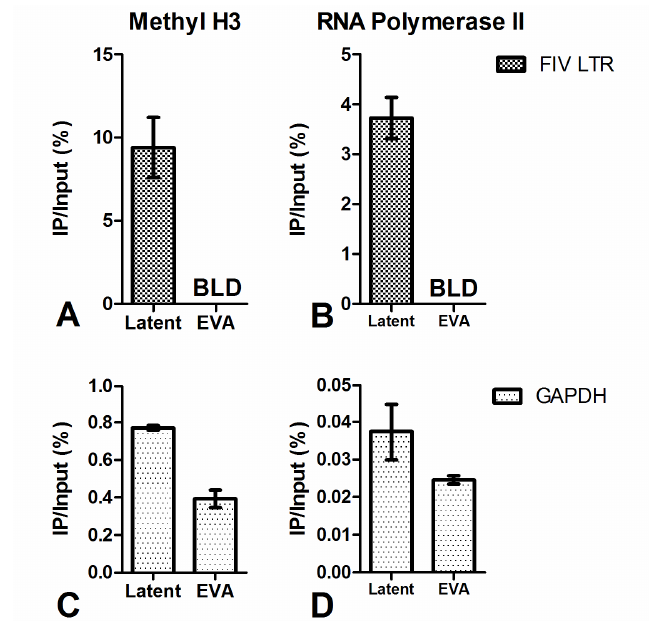
Figure 5. ChIP assay of FIV-infected CD4+ T-cells using anti-methylated histone H3 and anti-RNA Polymerase II antibodies. ( A ) The FIV promoter of latently-infected, but not ex vivo activated (EVA) [5], CD4+ T-cells is associated with methylated H3; ( B ) The FIV promoter of latently-infected, but not ex vivo activated (EVA), CD4+ T-cells is associated with RNA Polymerase II; ( C,D ) GAPDH positive controls are shown for A and B respectively. Data are presented as the percentage of immunoprecipitated (IP) DNA out of the total input DNA with background subtraction using a normal IgG control. Error bars represent the standard deviation of triplicate qPCR measurements, and data is representative of ChIP experiments repeated in two different cats (A/C: cat #184 and #187, B/D: cat #165 and #187) between 29 and 32 months post FIV